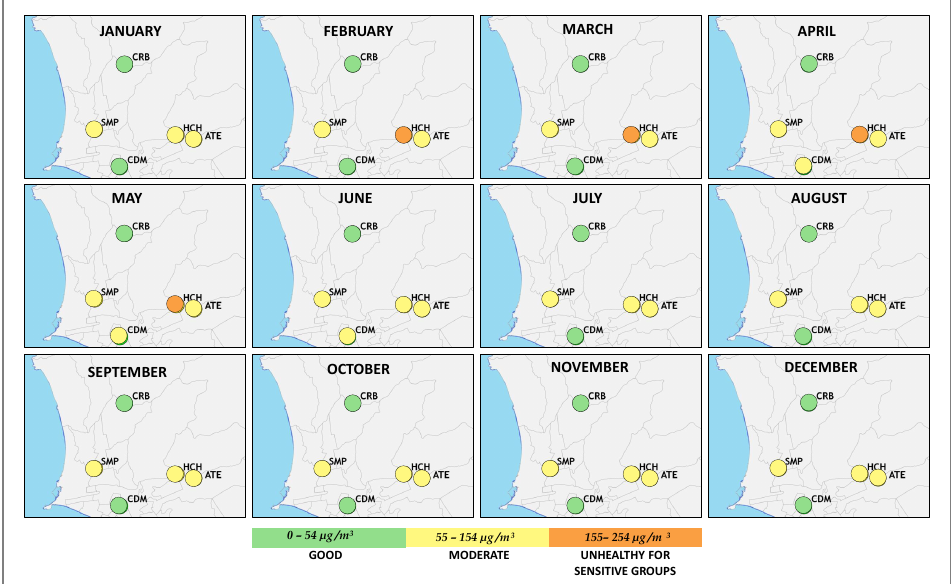
Figure 11. Heat maps with the monthly averages of PM 10 concentration in 2018 for each monitor- ing